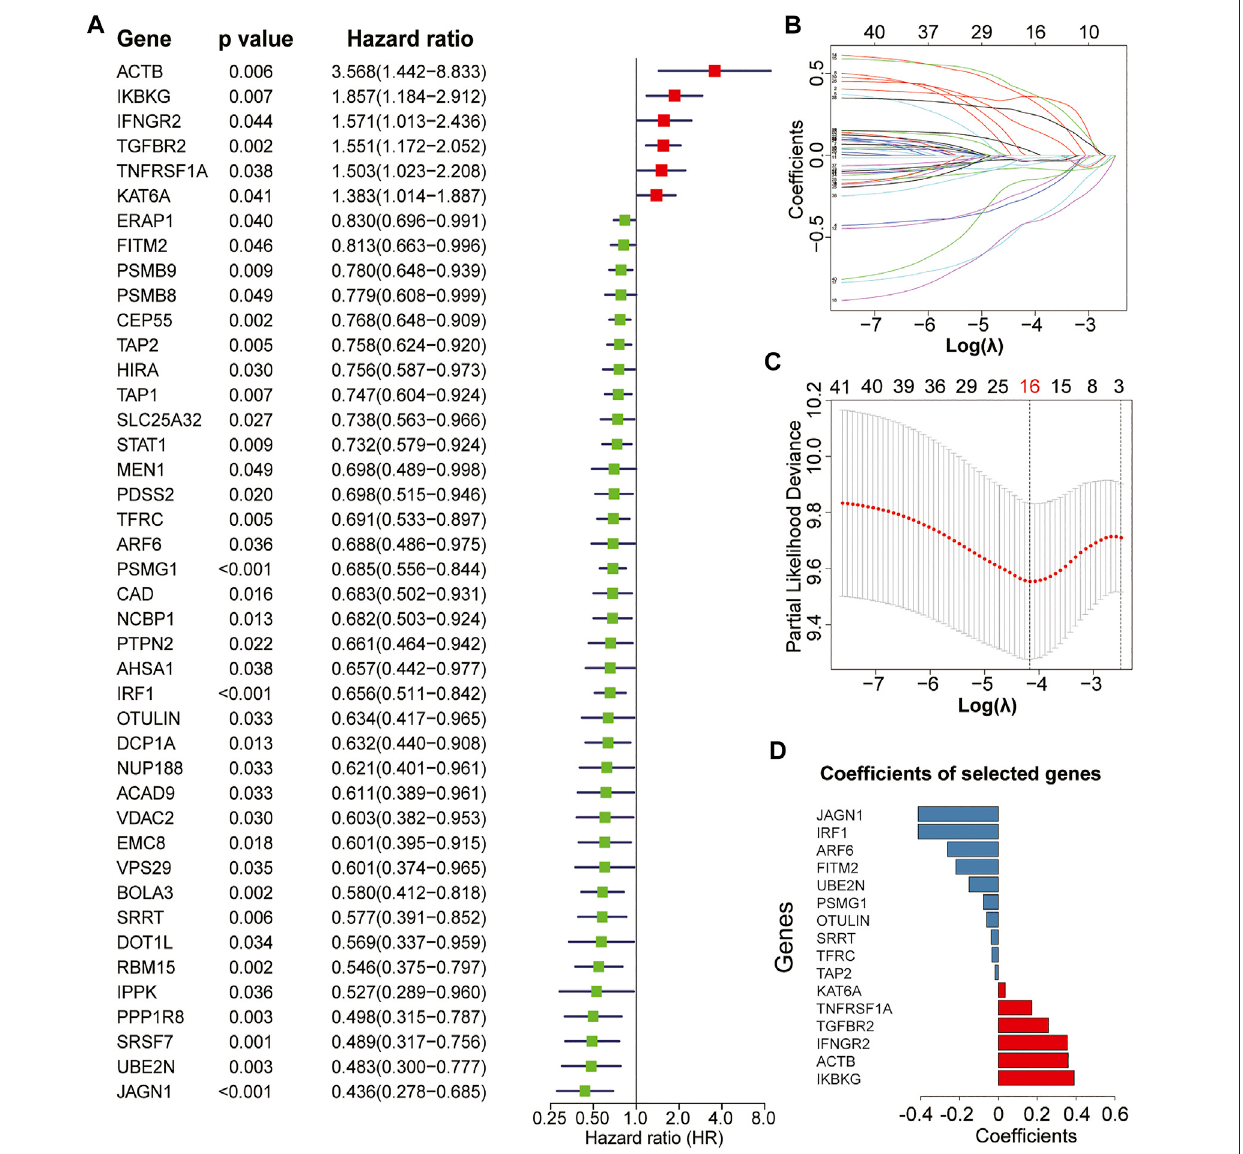
FIGURE2| Establishmentoftheimmuneevasion-relatedgenes(IEVG)signaturemodel. (A) univariateCoxregressionscreeningofthe42recurrence-freesurvival- related IEVGs screened from 182 IEVGs in the GSE39582 training cohort. (B) The coef fi cient pro fi les of the 42 prognostic IEVGs in the Lasso regression model from the training cohort (GSE39582). (C) Partial likelihood deviance ofIEVGs included in the Lasso regression model. (D) Coef fi cients ofthe 16 screened IEVGs in the Lasso Cox regression model.